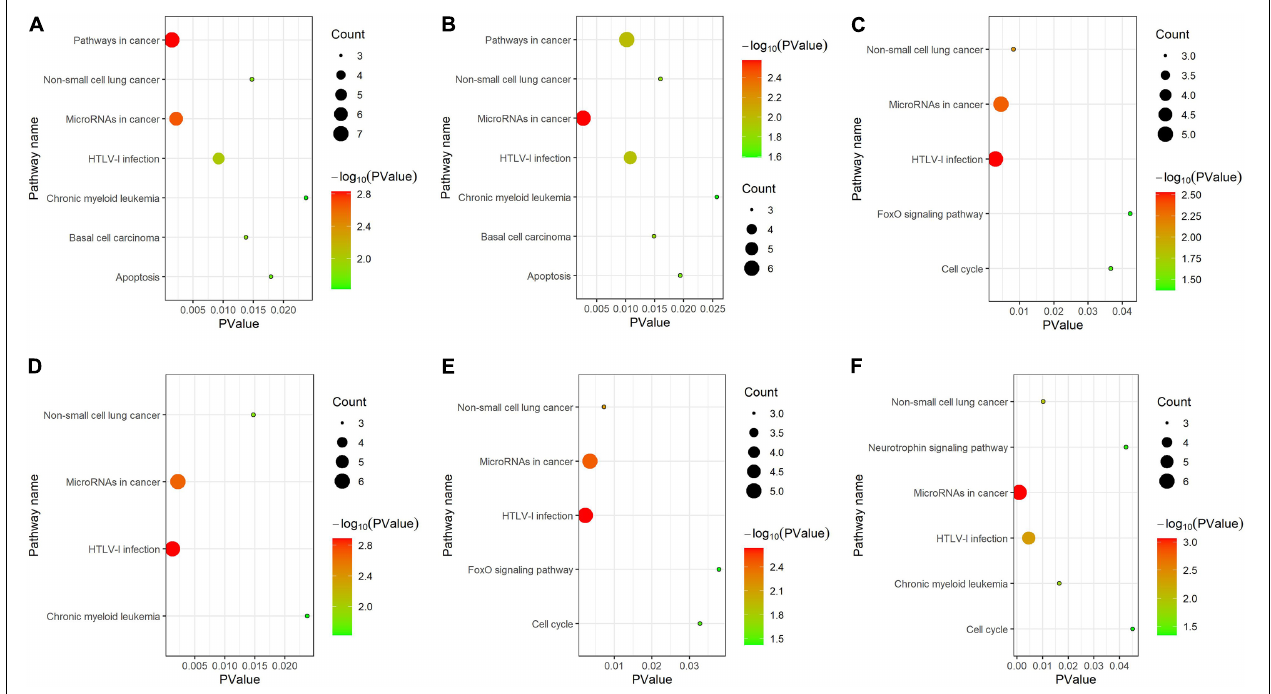
FIGURE 6 | KEGG pathway analysis for (A–F) six